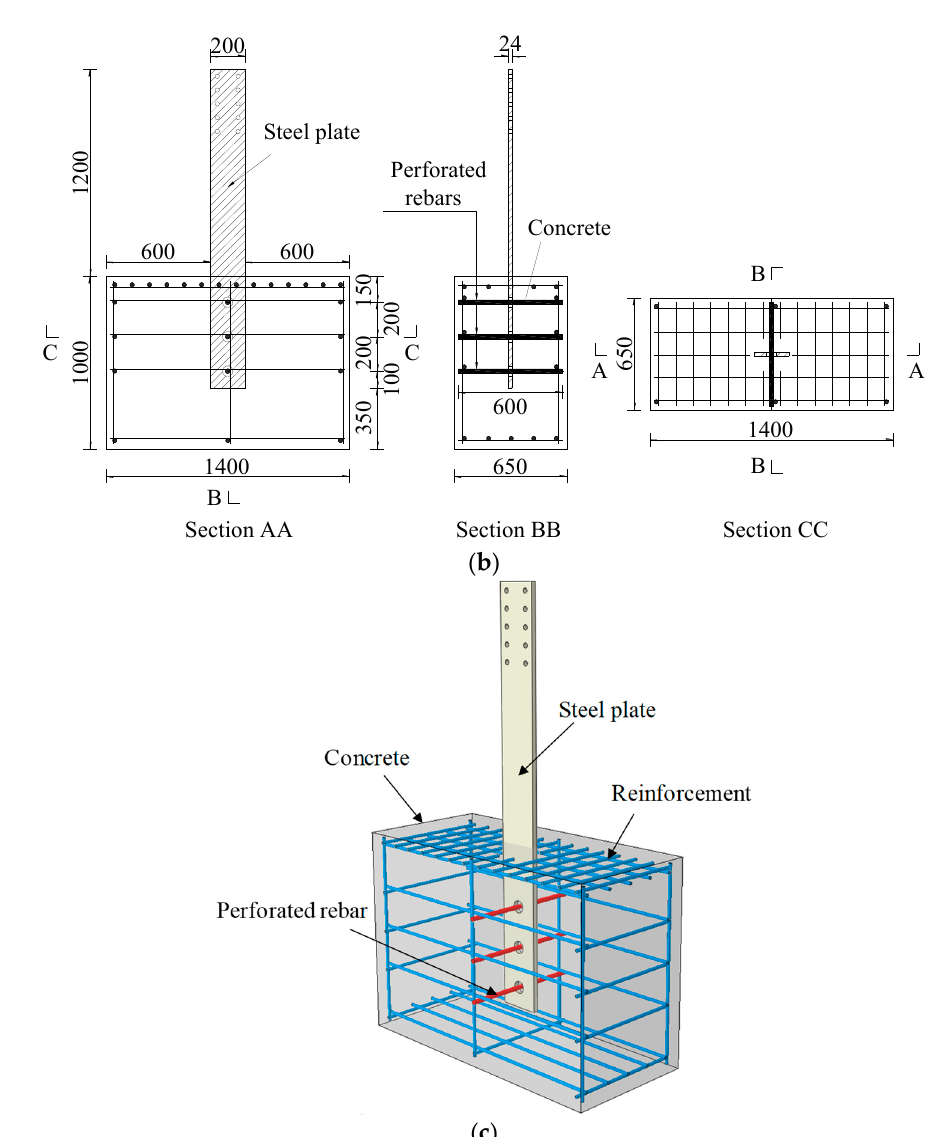
Figure 1. Details of the pull-out specimens. ( a ) configuration and geometry of specimen PA; ( b ) configuration and geometry of specimen PB; ( c ) 3D diagram of the pull-out specimen. Table 1. Mechanical properties of materials.